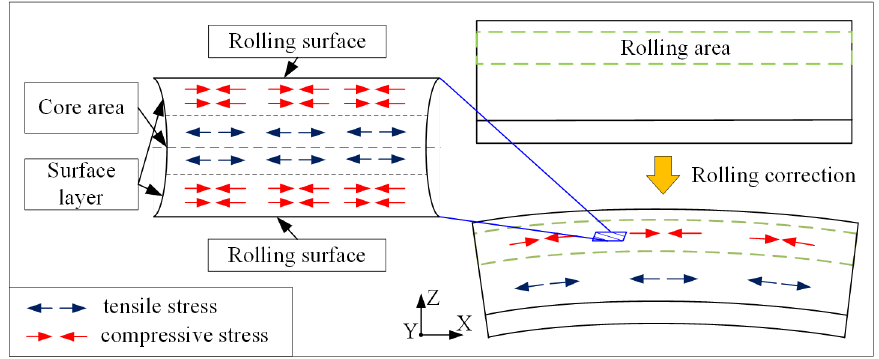
Figure 12. Rolling area and overall macroscopic stress distribution of samples after rolling correc-